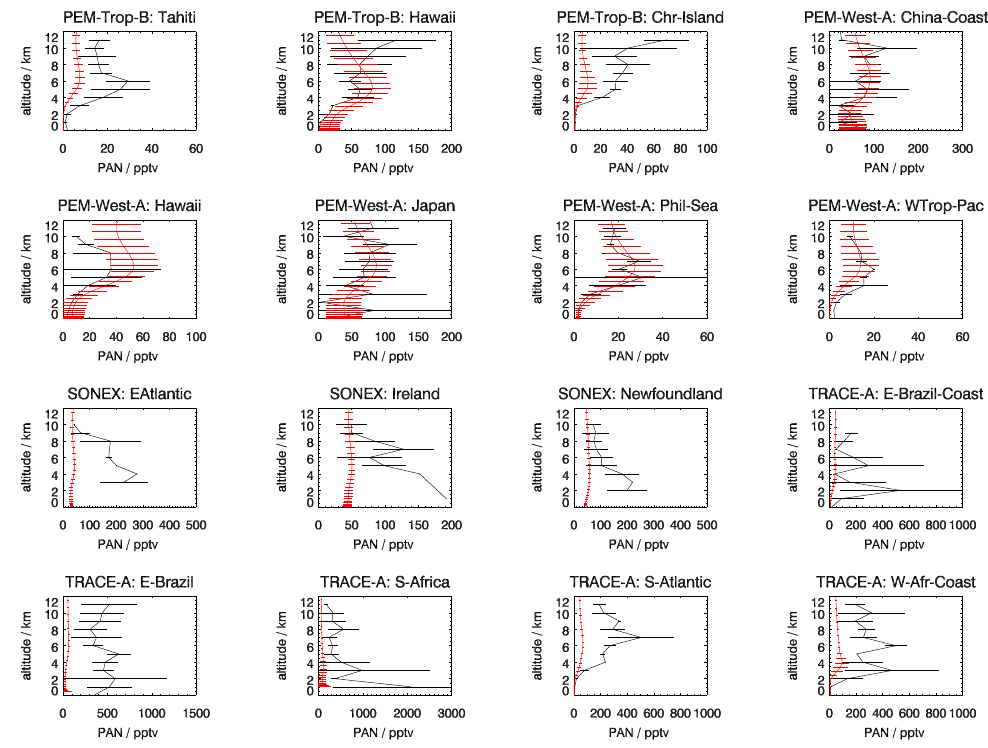
Fig. 21. Comparison between regional vertical profiles of modelled (red) and observed (black) PAN from various aircraft campaigns compiled into data composites by Emmons et al. (2000). In each case, the mean concentration in each altitude bin is plotted and the horizontal lines represent the mean ± 1 standard deviation.